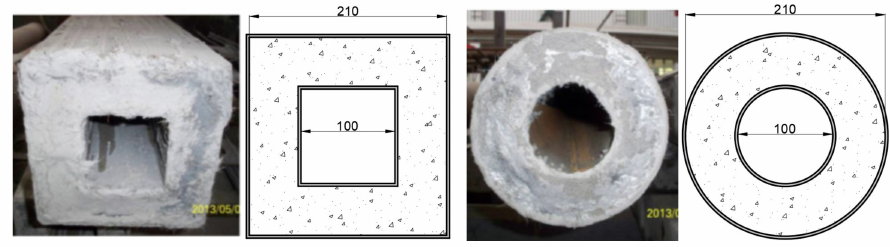
Figure 9. Cross-sections of two CFDST specimens [20]. Copyright permission obtained from authors.